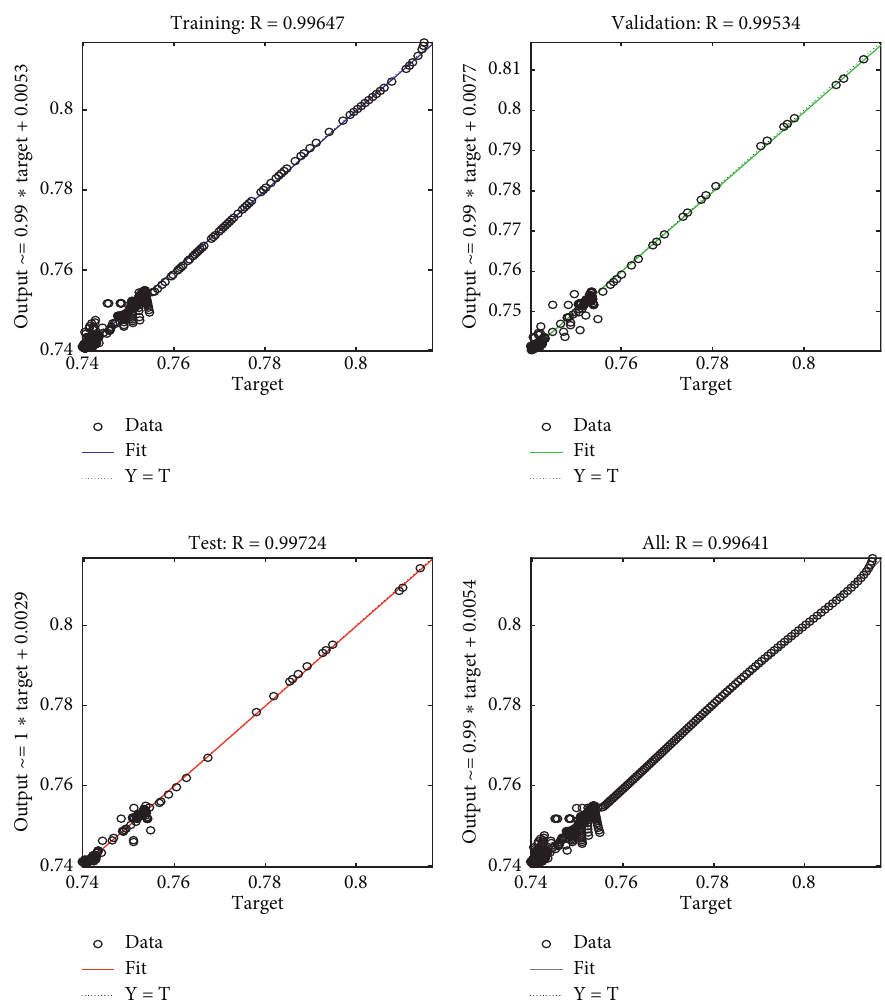
Figure 41: The regression results of the trained neural network for training, testing, and validation. Table 6: The remote seismic node electrical specifications. Unit Operating voltage (VDC)/power (W) Seismometer